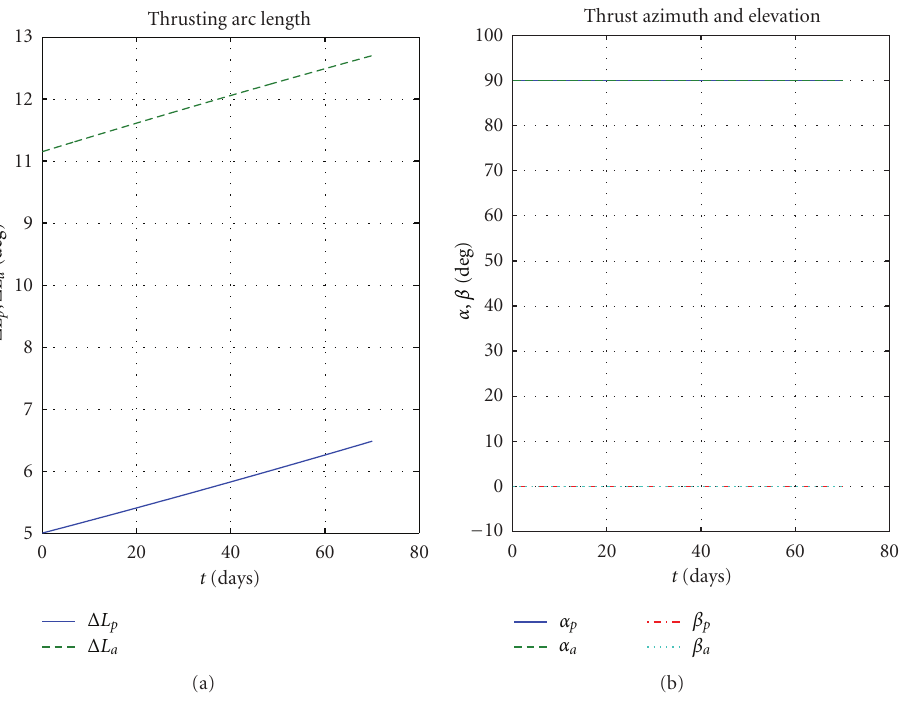
Figure 8: Control parameters for multi-revolution orbital transfer (coplanar case): (a) thrust arc length; (b) azimuth and elevation.